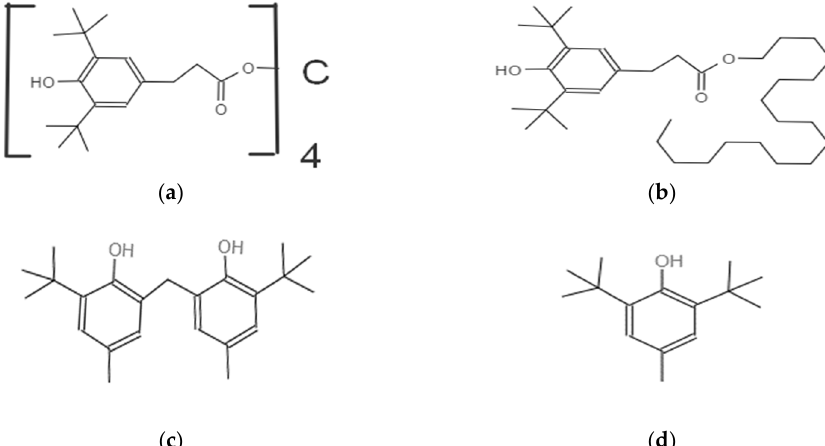
Figure 1. Structures of the antioxidants: ( a ) Irganox 1010 (penthaeritrytetetraoxy(3-(3,5-ditert-buthyl-4-hydroxyphenyl)propyonate); ( b ) Irganox 1076 (octadecyl-3-(3,5-ditert-buthyl-4-hydroxyphenyl)-propyonate); ( c ) Vulkanox BKF (2,2-methylene-bis(4-methyl-6-tert-buthylphenol); ( d ) Vulkanox BHT (4-methyl-2,6-ditert-buthylphenol).